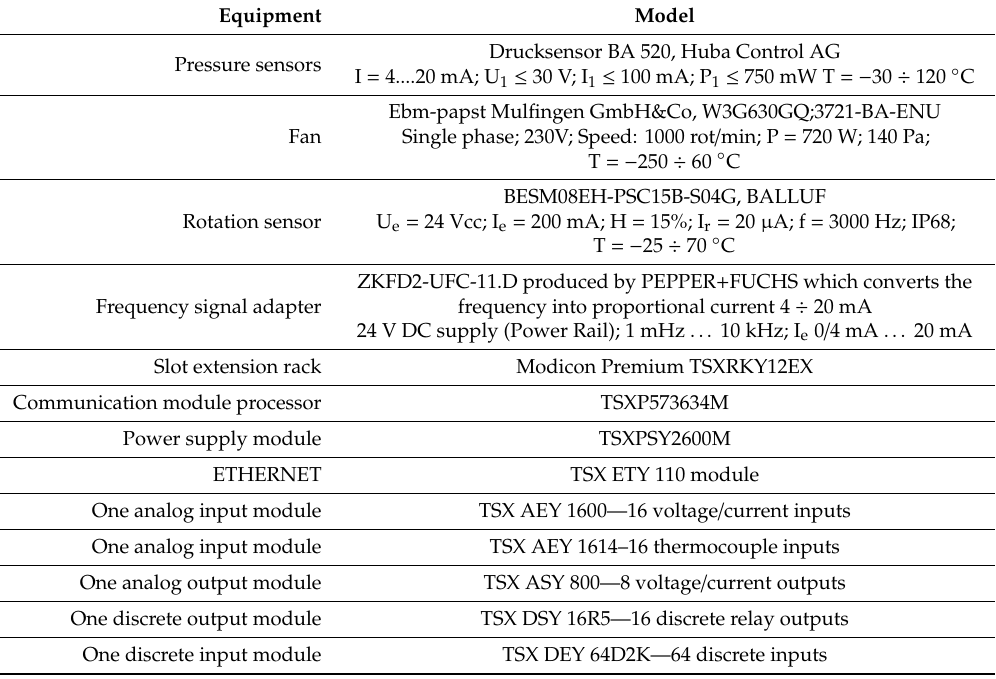
Table 1. Monitored / controlled Table 1. Monitored/controlled equipment.